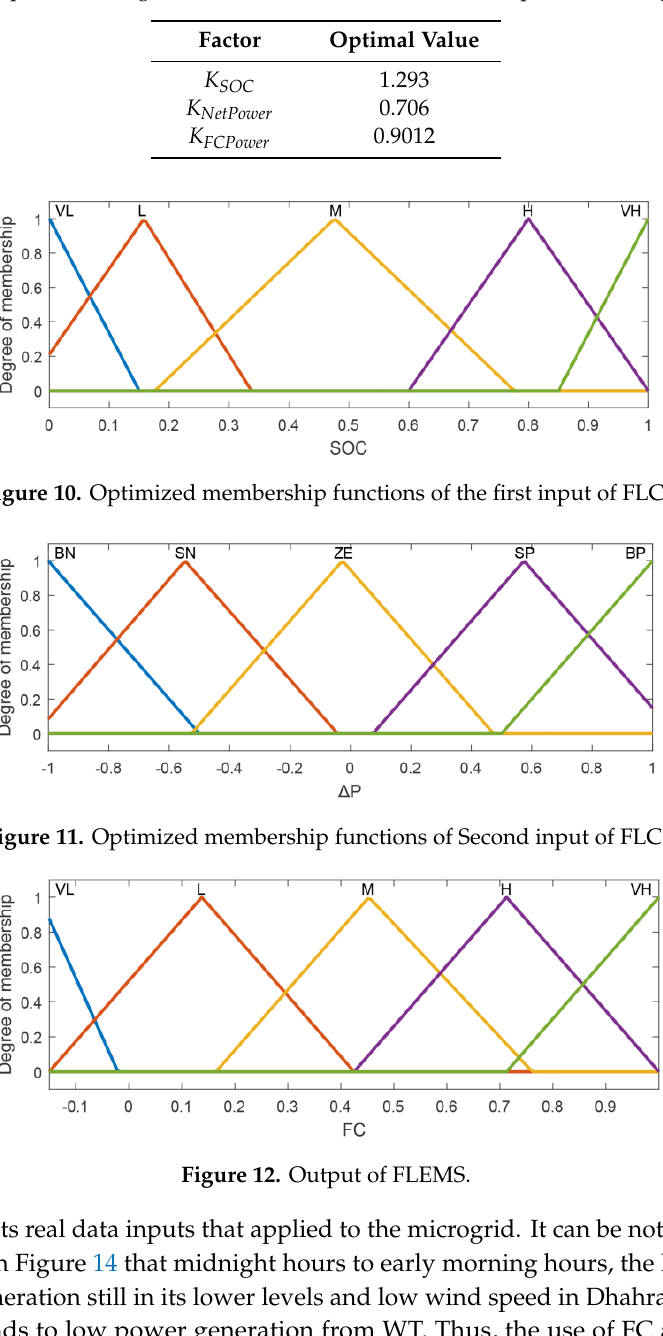
Figure 9. Conversion of fuzzy logic controller (FLC) optimization using ABC by 100 iterations. Table 3. Optimal scaling factors for FLC obtained from ABC optimization algorithm.